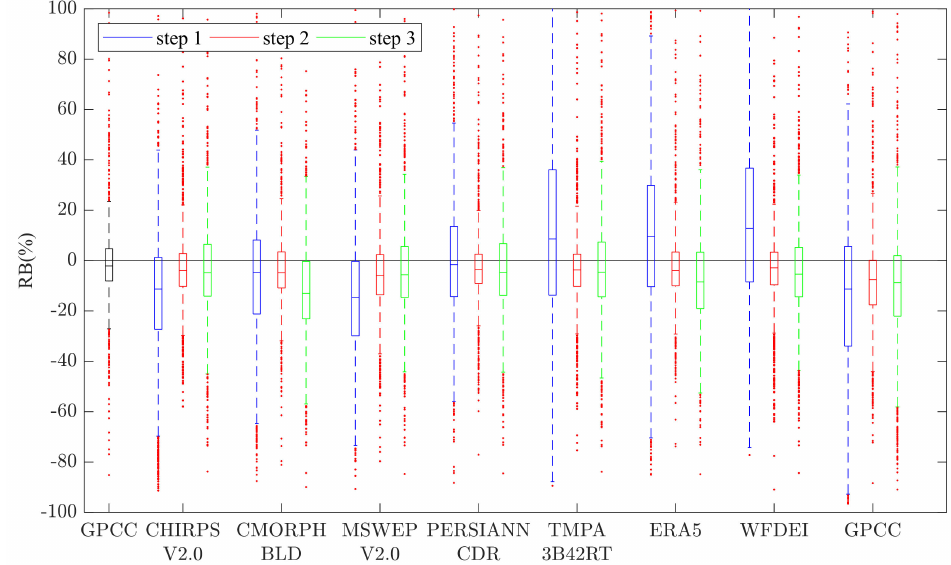
Figure 8. Boxplots of RB for annual streamflow volume simulated by gauge-observed precipitation (Obs) and the eight PPs, with the observed streamflow over 1382 catchments as a reference. Boxplot representation is the same as Figure